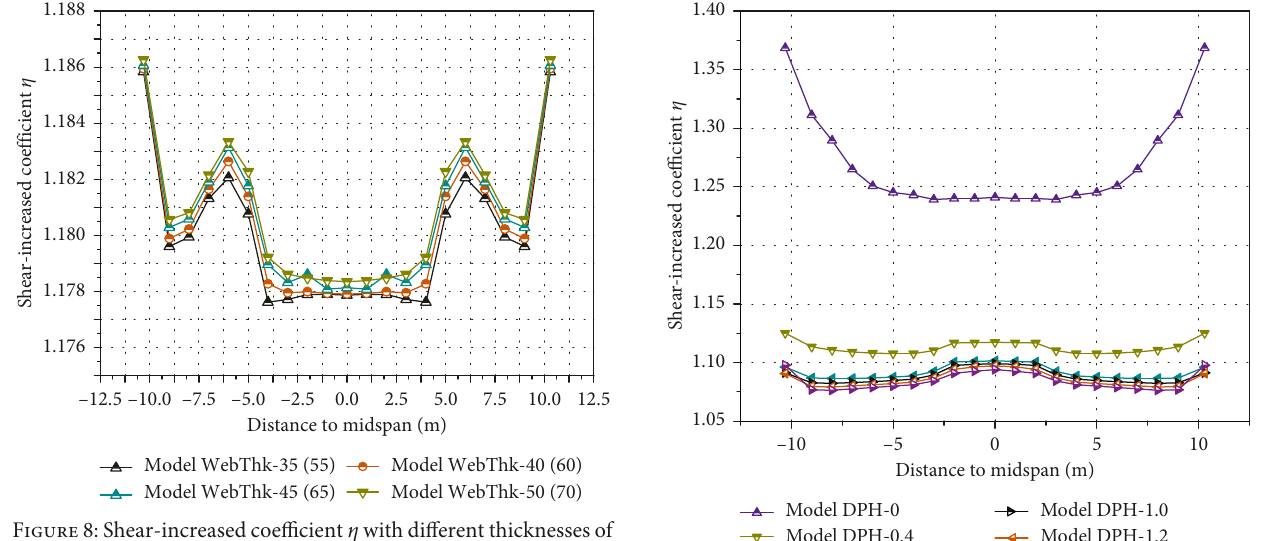
Figure 8: Shear-increased coefficient η with different thicknesses of the web cases.